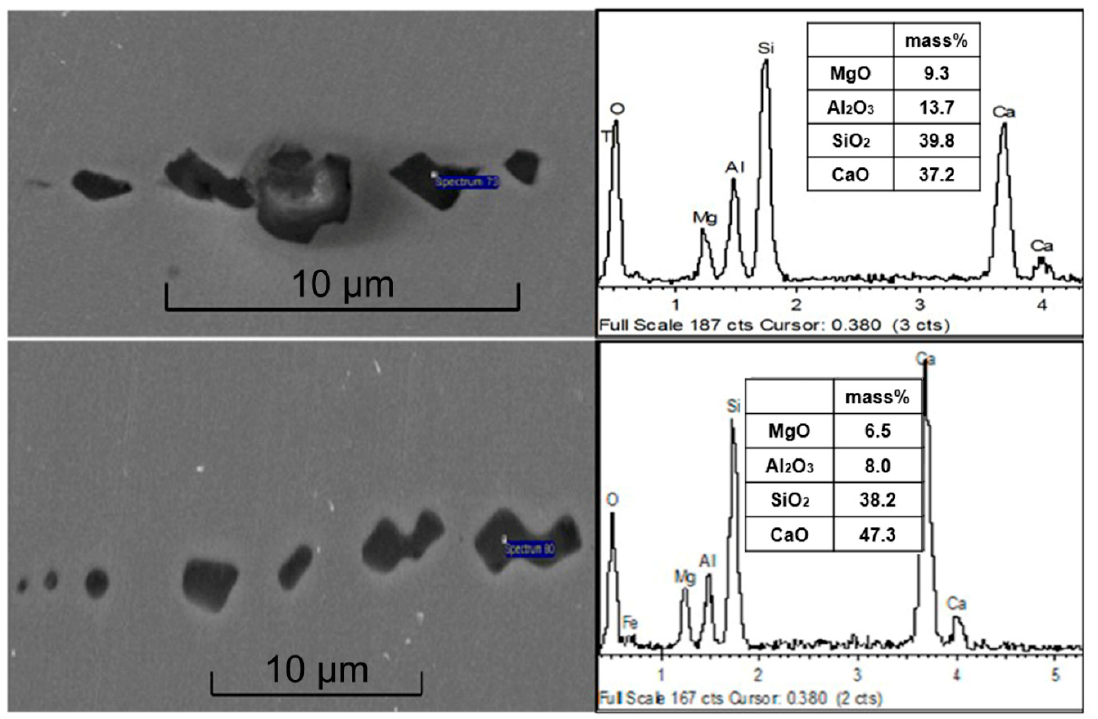
Figure 9. SEM images and EDS results of inclusions in hot rolled plates when using ultra-purity FeSi alloy during AOD reduction.